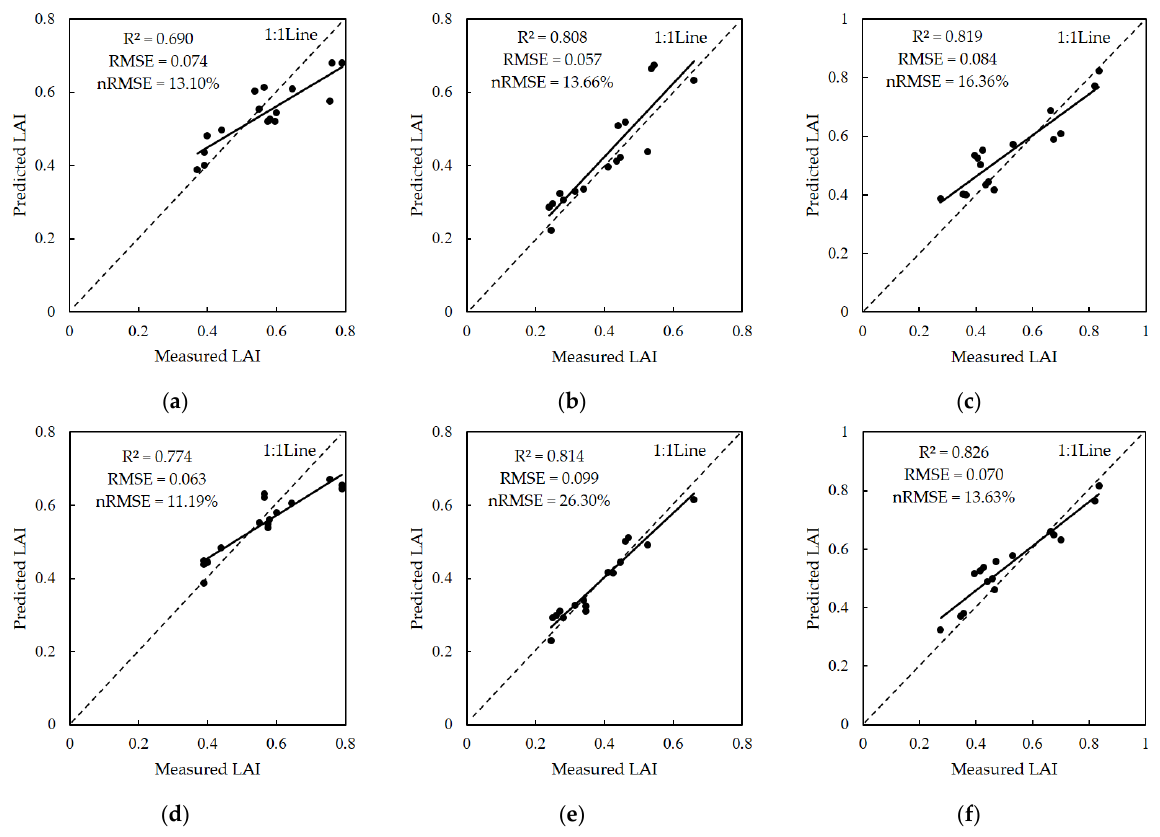
Figure 6. Validation results of spectral parameters model for SWR and RFR models in each growth stage. ( a ) With SWR model in initial flowering stage (IF); ( b ) with SWR model in young fruit stage (YF); ( c ) with SWR model in fruit enlargement stage (FE); ( d ) with RFR model in initial flowering stage (IF); ( e ) with RFR model in young fruit stage (YF); ( f ) with RFR model in fruit enlargement stage (FE). Table 7. Comparison of SWR and RFR analyses for combined texture features in each growth